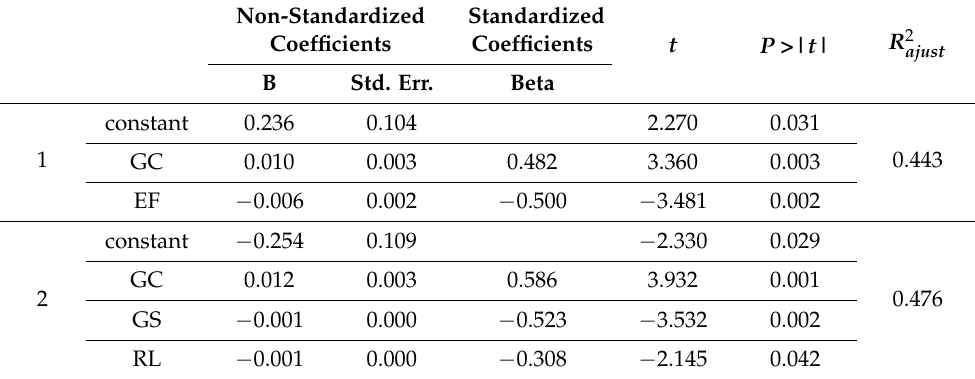
Table 5. Linear regression result: DEA overestimation